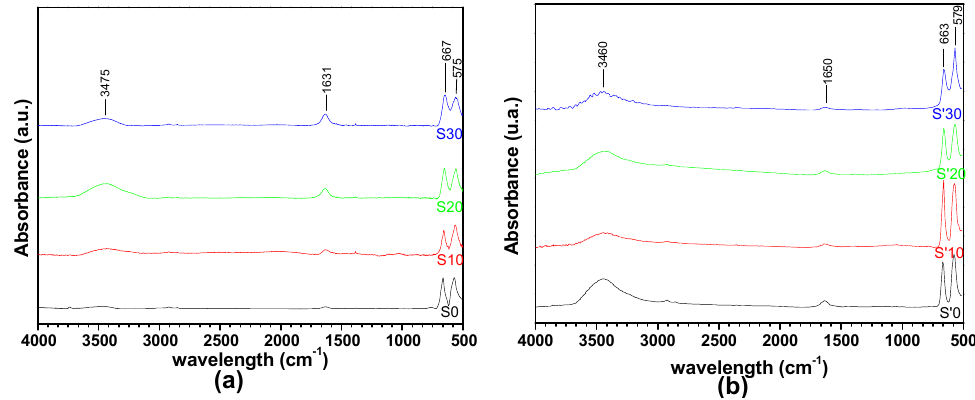
Figure 4. Infrared (IR) spectra of the decomposition products obtained from ( a ) S samples (S0, S10, S20, S30) calcined at 400 °C and ( b ) S’ samples (S’0, S’10, S’20, S’30) calcined at 600 °C.